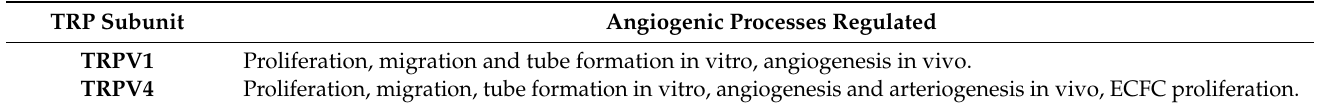
Table 2. Angiogenic processes regulated by TRPV subunits.